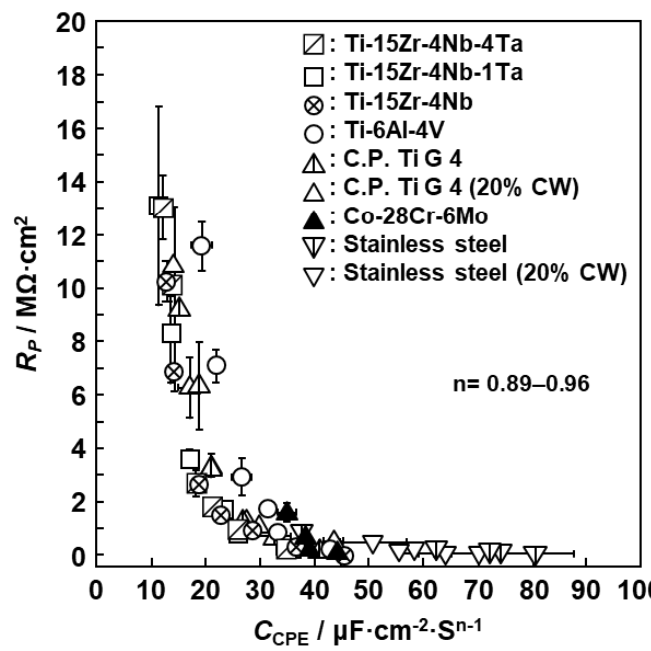
Figure 12. Relationship between resistance (R P ) and capacitance (C CPE ) of oxide films formed on various metals in the anodic polarization test up to 1 V vs. SCE in 0.9% NaCl at 37 ◦ C after polishing with 1000-grit emery paper.